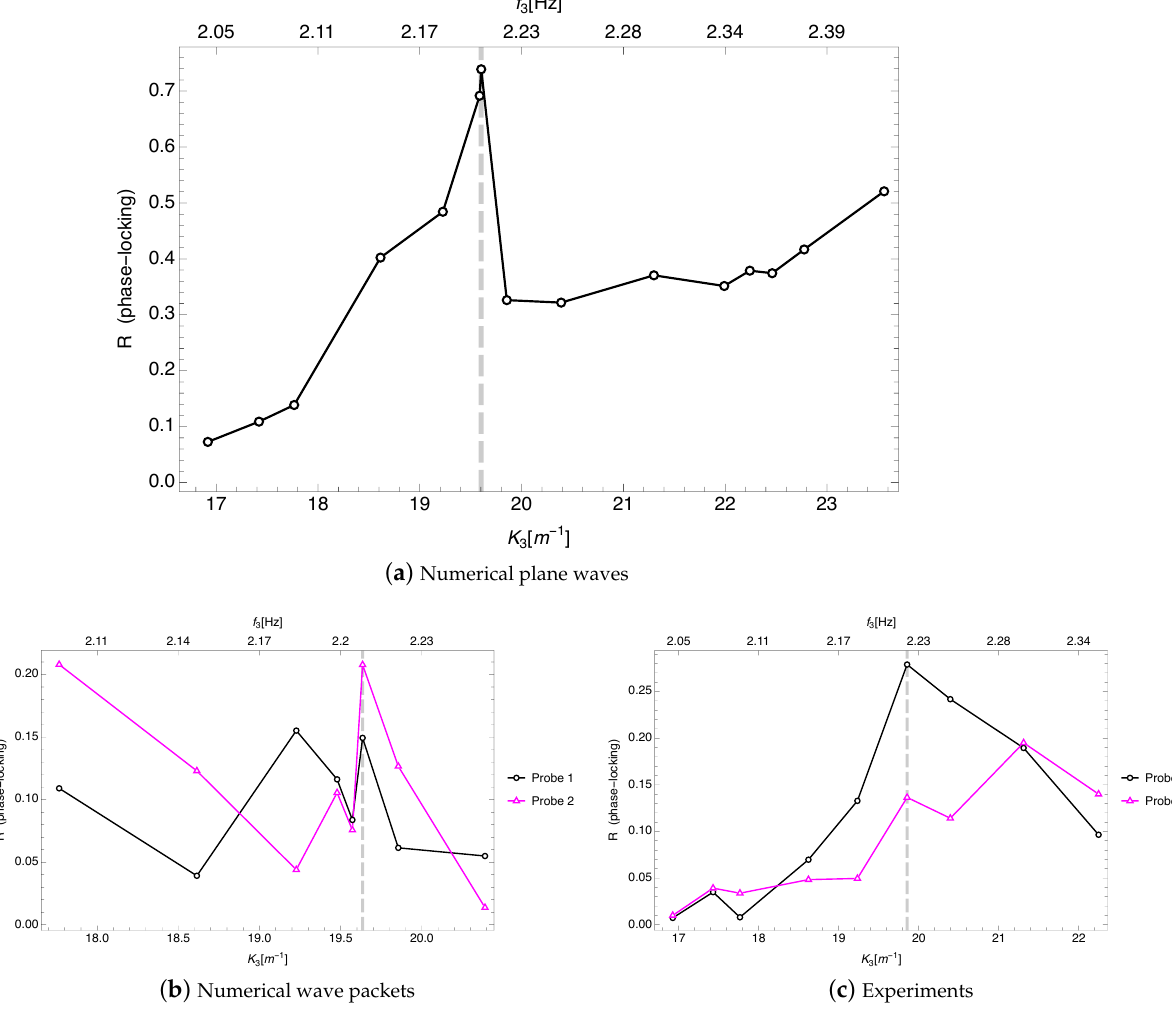
Figure 19. Phase-locking values of analytic-signal-approach triad phases, Equations (30) and (31), obtained from probe data, for different experiments within the three scenarios studied in this paper: ( a ) Encountering numerical plane waves; ( b ) encountering numerical wave packets; ( c ) encountering experimental waves. In all three scenarios, a clear local maximum of the phase-locking value is attained at the predicted resonance, corresponding to the maximum in efficiency for each case, cf. Figures 6, 11 and 18, respectively. In all panels, the dashed grey vertical line corresponds to the theoretical resonant case K 1 : K 2 : K 3 = 16 : 9 :